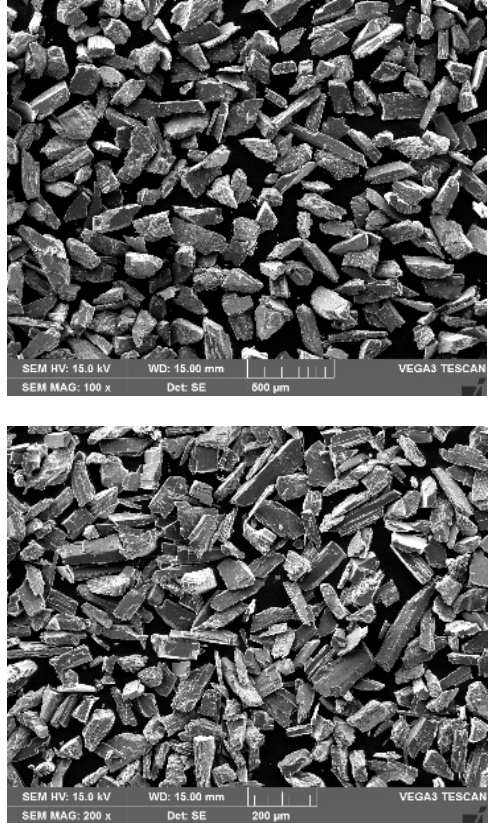
Figure 10. Representative SEM images for the 80–150 μ m (top) and 40-80 μ m (bottom) fractions (The scale of the top and bottom images are 600 and 200 μ m, respectively).